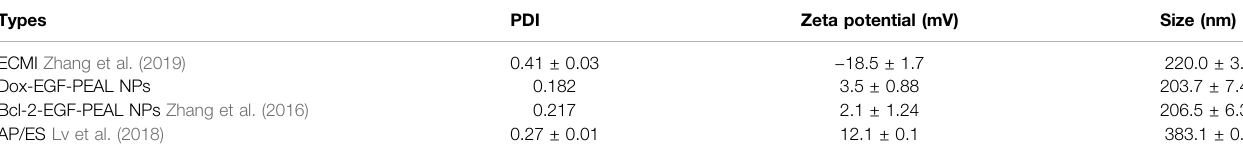
TABLE 5 | EGFR antibody for active targeting of nanoparticle drug delivery systems.